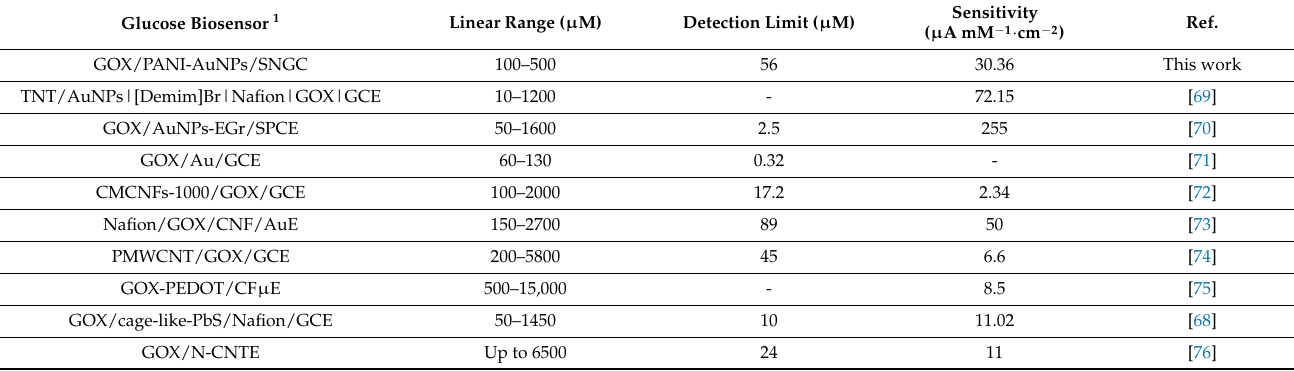
Table 2. Comparison of analytical performance between GOX/PANI-AuNPs/SNGC electrode and other modified biosensors. Glucose Biosensor 1 Linear Range ( µ M) Detection Limit ( µ